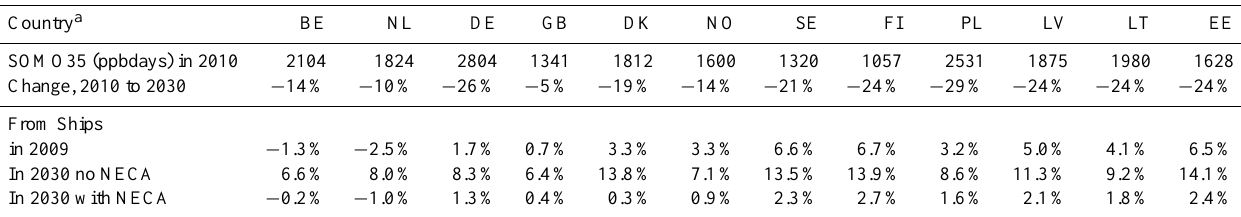
Figure 7. Year 2030 model calculated annually averaged: (a) PM 2 . 5 concentrations, (b) deposition of nitrogen, (c) SOMO35 and (d) YOLLpp. Table 5. SOMO35 per country calculated with 2010 emissions (ship emissions in the Baltic Sea and the North Sea for 2009). Also listed are the percentage reductions from 2010 to 2030 under current regulation (second row), and the percentage share from shipping calculated with ship emissions for 2009 relative to the 2010 land-based emissions. The percentage contribution from shipping in 2030 is listed both with and without a NECA implemented in the two sea areas (last two rows). Negative percentage contributions mean an increase in calculated